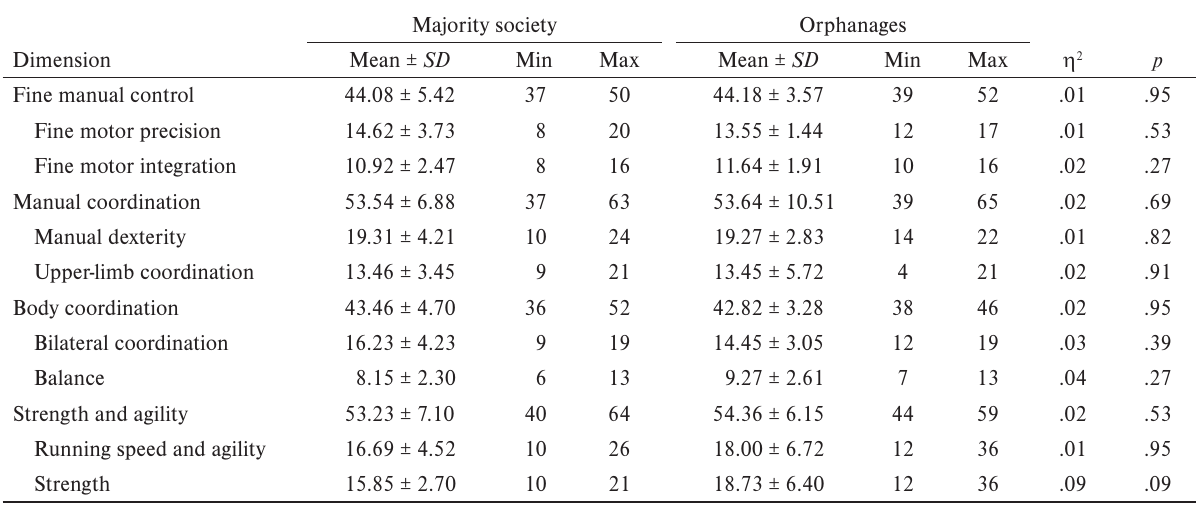
Table 3 Descriptive statistics of the results of BOT-2 dimensions for girls from majority society and from orphanages